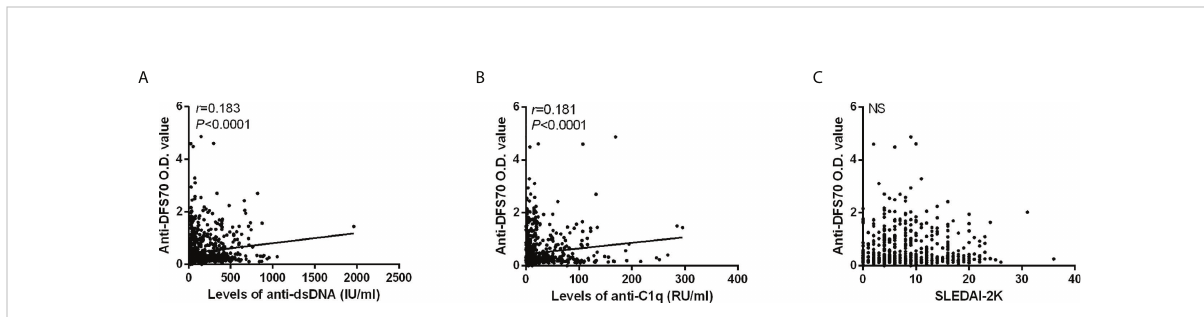
FIGURE 2 Correlations of anti-DFS70 O.D. value by ELISA with markers of disease activity in 851 SLE patients. Correlation of O.D. value of anti-DFS70 antibodies with the levels of anti-dsDNA antibodies (A) , anti-C1q antibodies (B) , and SLEDAI-2K (C) . DFS70, dense fi ne speckles 70; ELISA, enzyme-linked immunosorbent assay; NS, no signi fi cance; O.D. value, optical density value; r , correlation coef fi cient; SLEDAI-2K, Systemic Lupus Erythematosus Disease Activity Index